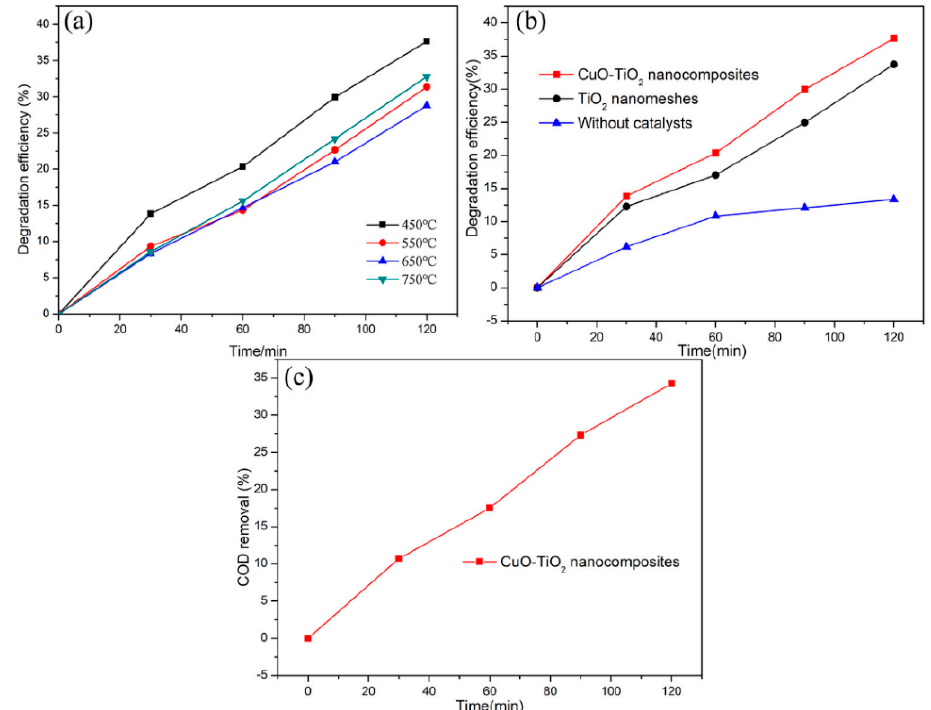
Figure 4. ( a ) Photocatalytic degradation efficiencies of MB at different calcined temperatures after Cu electrodeposition; ( b ) photocatalytic degradation efficiencies of MB of CuO-TiO 2 nanocomposites, TiO 2 nanomeshes and without catalysts.; ( c ) COD removal rate of CuO-TiO 2 nanocomposites.